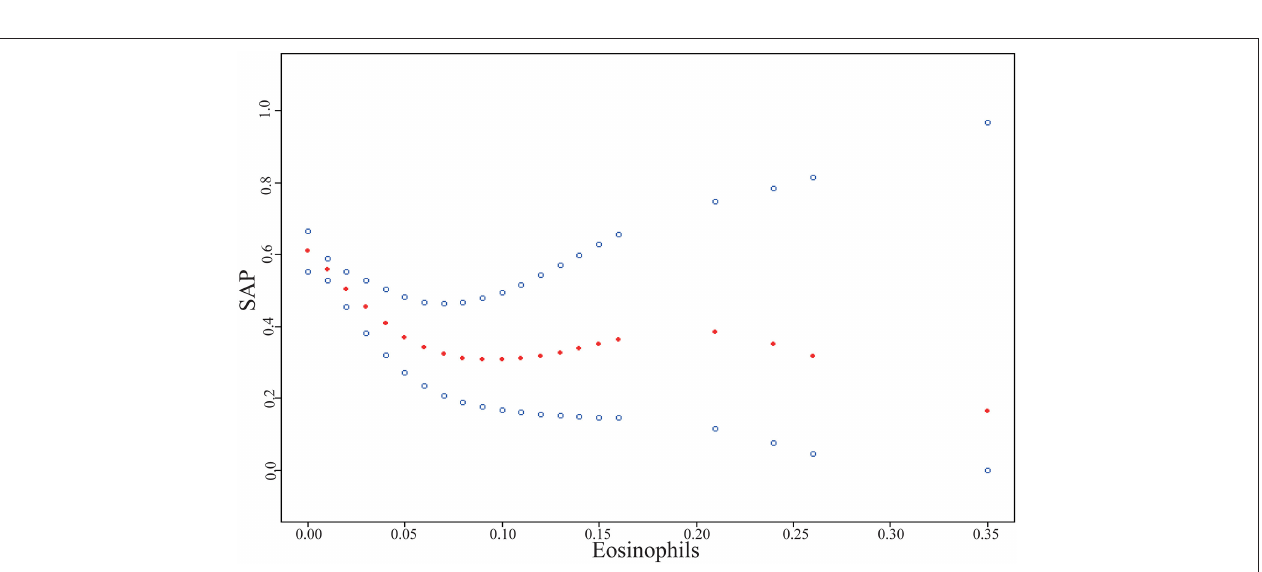
FIGURE 1 | The non-linear relationship between eosinophils and stroke-associated pneumonia (SAP) in patients with acute ischemic stroke experiencing mechanical thrombectomy. A non-linear relationship between them was detected after adjusting for age, hyperlipidemia, baseline National Institutes of Health Stroke Scale (NIHSS), Alberta Stroke Program Early CT Score (ASPECTS), occluded artery, dysphagia, stroke etiology, and collateral